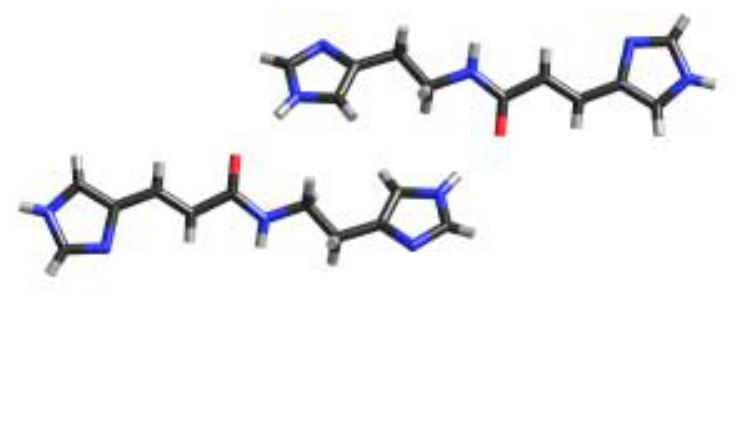
Figure 1. X-ray crystal structure of 1 illustrating the intermolecular NH…O hydrogen bonded